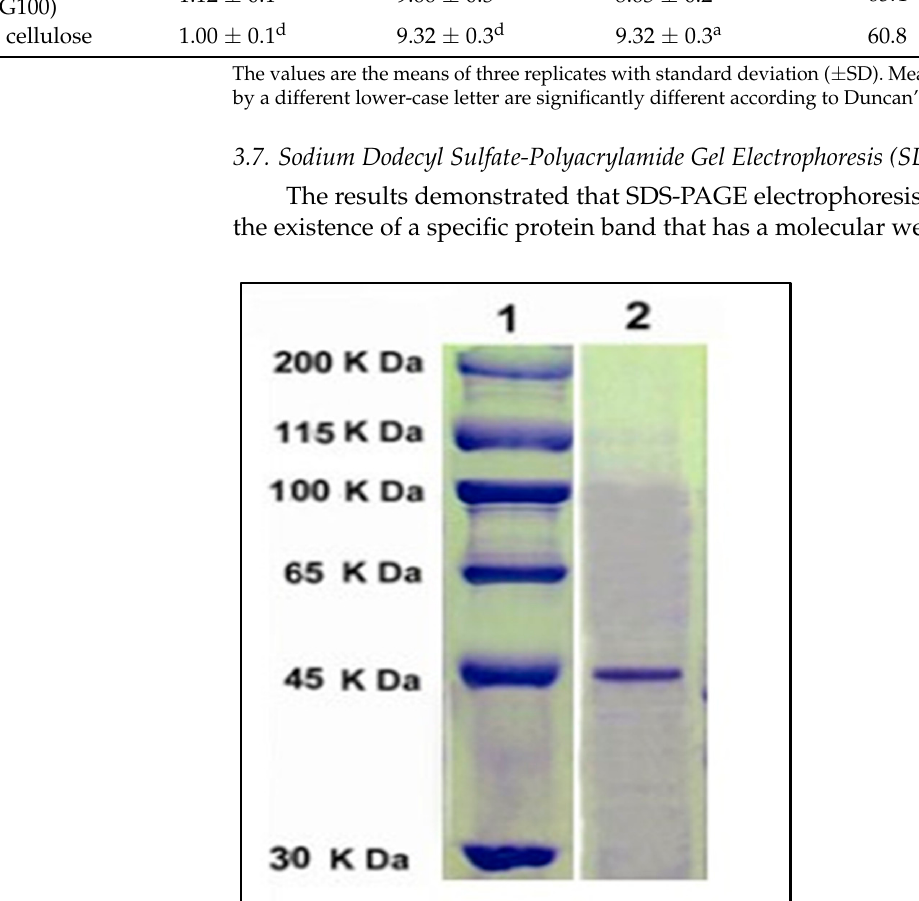
Figure 7. SDS-PAGE of purified chitinase from T. funiculosus strain CBS 129594. Lane 1, molecular weight standards (Marker), Lane 2, purified chitinase.